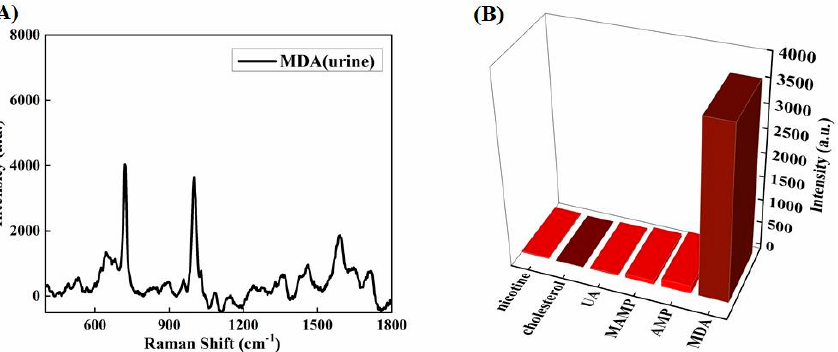
Figure 11. ( A ) Sandwich-structure-based SERS spectrum of MDA (1 µ g/mL) in urine. ( B ) Intensities of the SERS band at 714 cm − 1 for MDA and other interference species in urine samples.